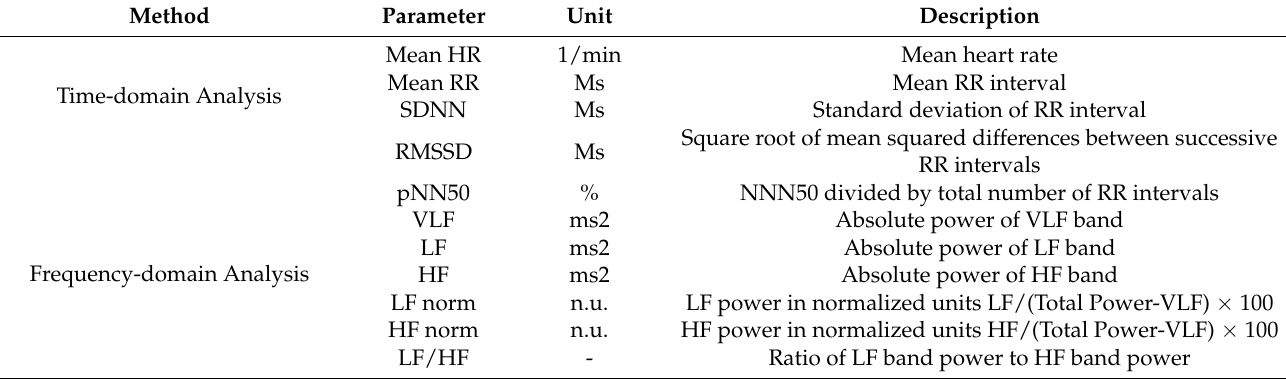
Table 1. Parameters for time-domain and frequency-domain analyses of heart rate variability (HRV) signals.